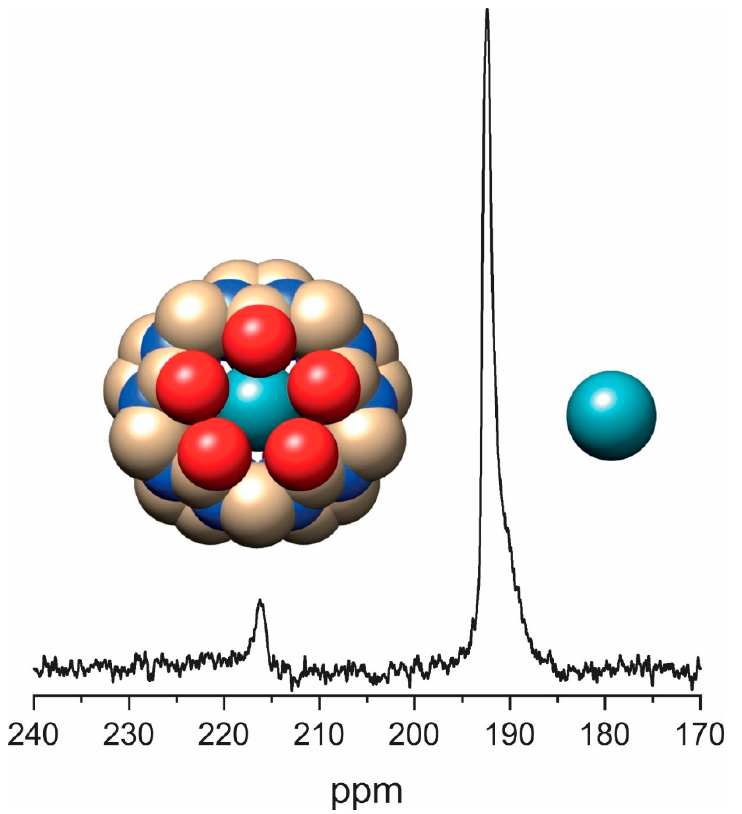
Figure 5. 129 Xe-NMR spectrum of a saturated solution of CB[5] in H 2 O with 13% Magnevist ® for relaxation enhancement in solution. The amount of dissolved Xe corresponds to 13.2 mM from 4 atm of Xe on top of the solution. Signal averaging with 5000 FID acquisitions, TR = 45 s, line broadening: 15 Hz (unpublished data from our lab).